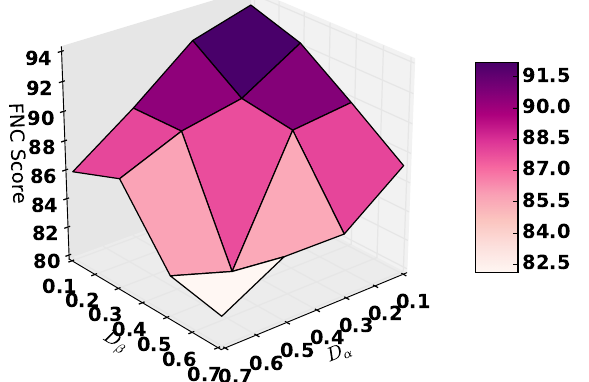
Figure 6. Dropout probabilities ( D α , D β ) and the performance of the